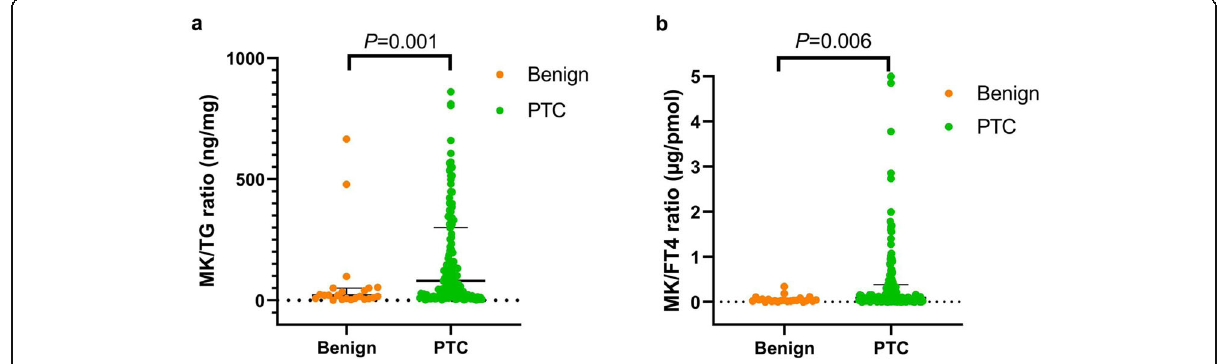
Fig. 2 Scatter plots of ( a ) midkine (MK)/thyroglobulin (TG) ratio and ( b ) MK/free thyroxine (FT4) ratio in patients with benign thyroid nodules versus papillary thyroid carcinomas (PTCs) confirmed by histopathology. Both MK/TG and MK/FT4 ratios were significantly higher for PTCs than for benign thyroid nodules ( P <